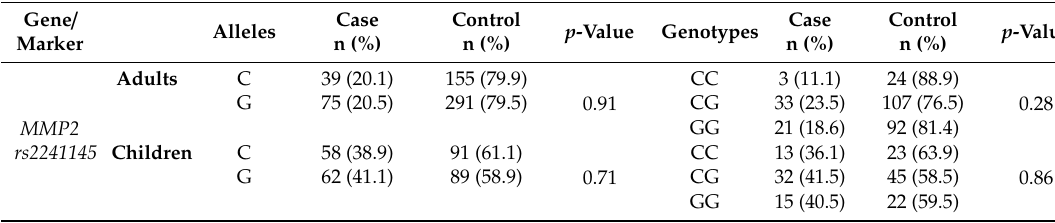
Table 3. Summary of the association